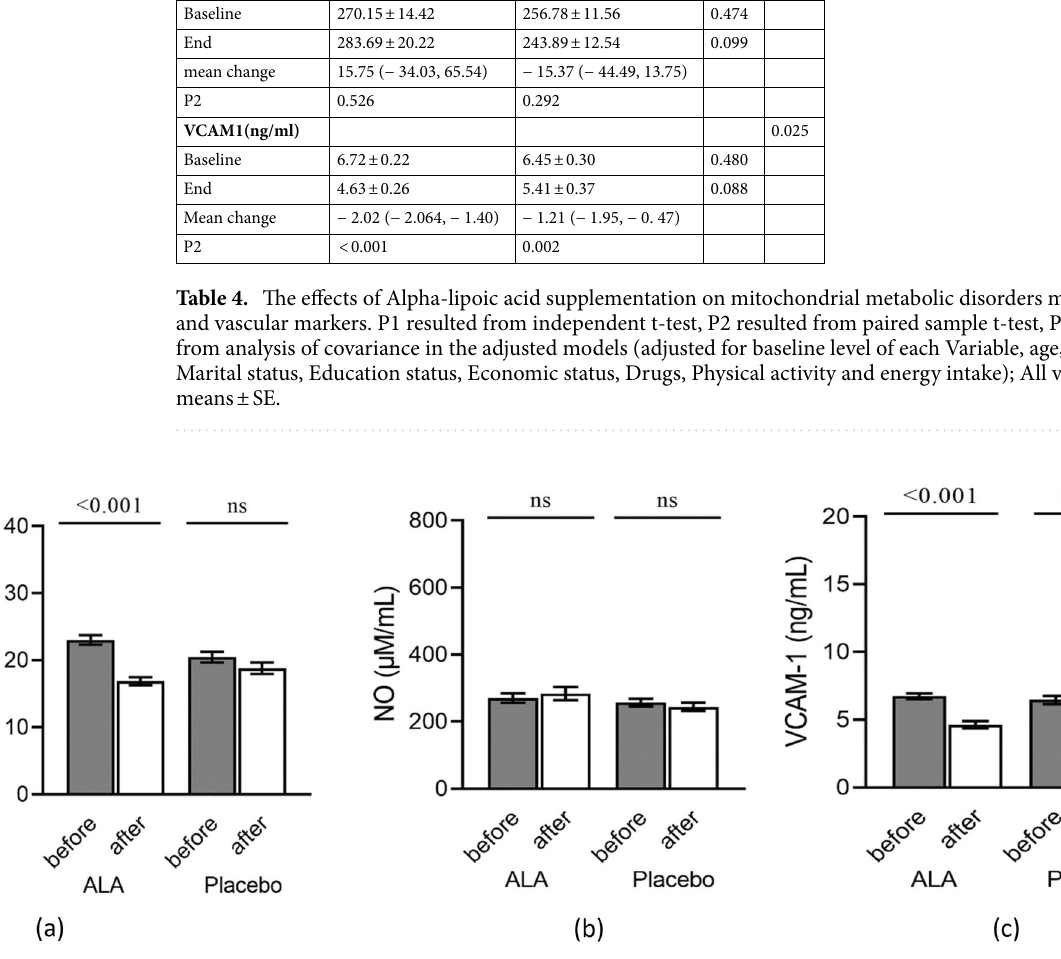
Figure 2. Comparison of biochemical variables between alpha-lipoic acid and placebo groups before and after the intervention. P resulted from paired sample t- test. ( a ) Lactate, ( b ) Nitric oxide (NO), ( c ) Vascular cell adhesion molecule-1